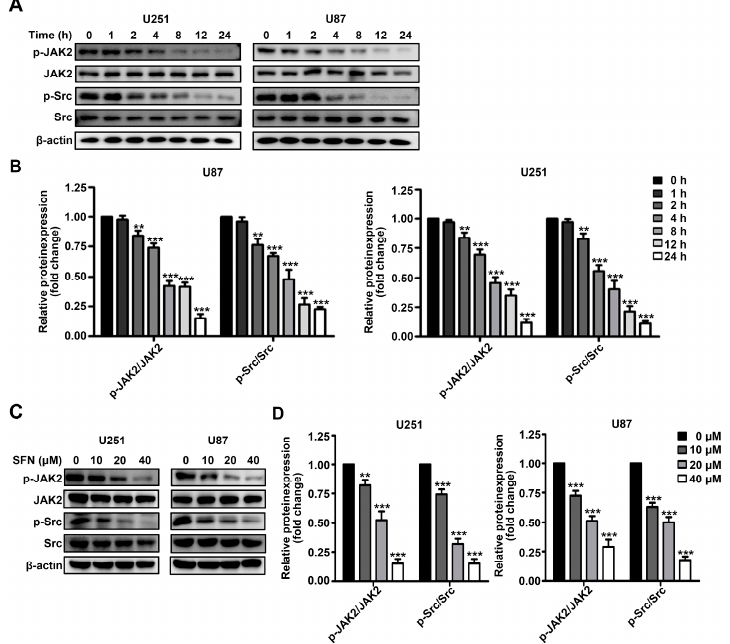
Figure 5. SFN inhibits phosphorylation of JAK2 and Src in GBM cells. ( A , B ) Cells were incubated with SFN (40 µM) for indicated time points; and ( C , D ) cells were treated with indicated concentrations of SFN and then harvested 24 h later. Whole-cell lysates were prepared and subjected to Western blot using anti-phospho-JAK2, anti-JAK2, anti-phospho-Src and anti-Src antibodies. The bands corresponding to each protein were quantified and normalized relative to band intensities for the control group. Data are represented as means ± SD. ** p < 0.01, and *** p < 0.001 versus control group.